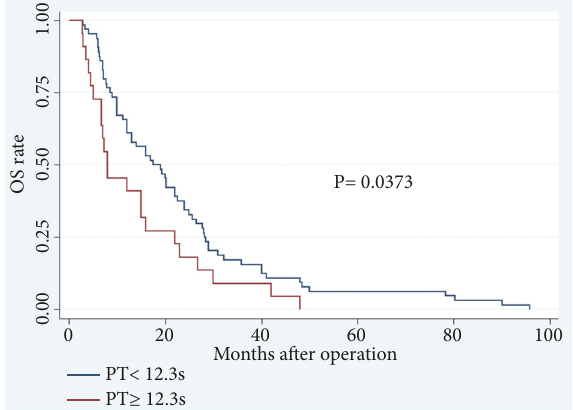
Figure 1: Overall survival in patients with cholangiocarcinoma according to PT levels (P=0.0373) (PT, prothrombin time; OS, overall survival).